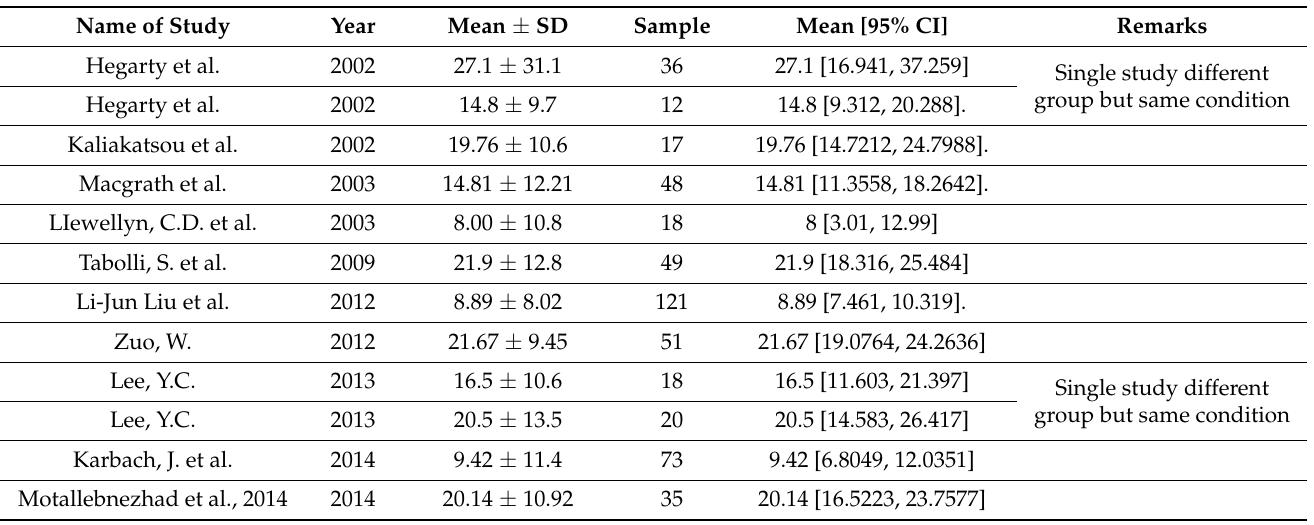
Table 4. Oral Health-Quality of Life associated with oral lichen planus using the Short-Form Oral Health Impact Profile (OHIP)-14